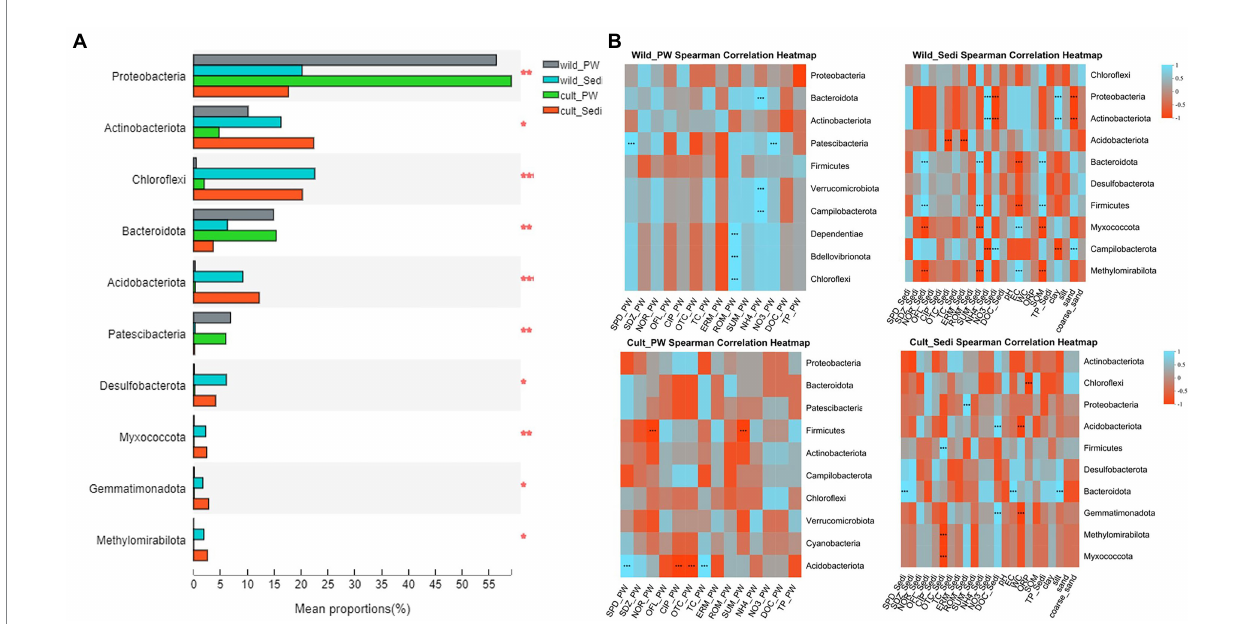
FIGURE 2 (A) One-way ANOVA analysis showed bacterial alpha difference between pore water and sediments in both Phragmites australis region and (B) spearman correlation between environmental factors and bacteria at the phylum level in the pore water and sediments from the wild and cultivated P. australis regions. PW, pore water; Sedi, sediments; SPD, sulfapyridine; SDZ, sulfapyridine; NOR, norfloxacin; OFL, ofloxacin; CIP, ciprofloxacin; OTC, oxytetracycline; TC, tetracycline; ERM, erythromycin; ROM, roxithromycin; and SUM, total